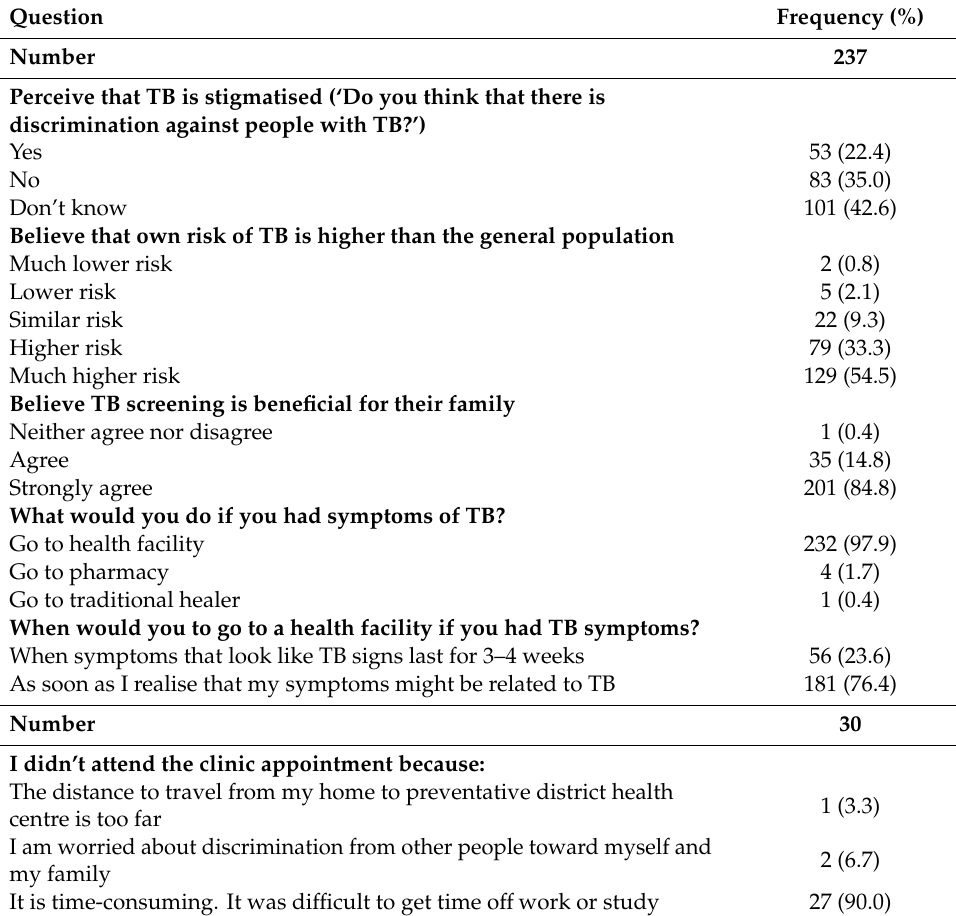
Table 3. Perceptions and practices in the whole cohort, and the subgroup of